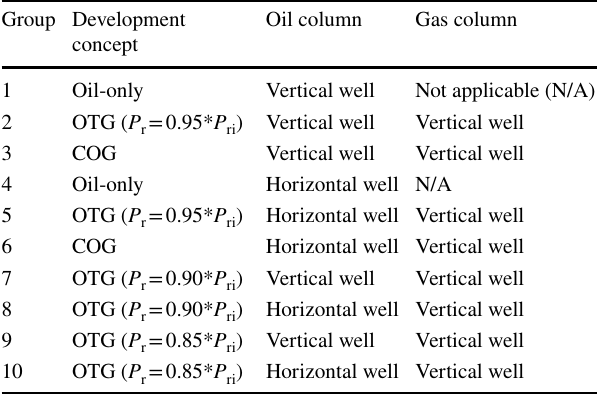
Fig. 3 A 2D view of the box model at the end of simulation for a case ( h g = 440 ft; K = 800 mD; oil-only development with a horizontal oil producer). Colour notations are the same as described in Fig.